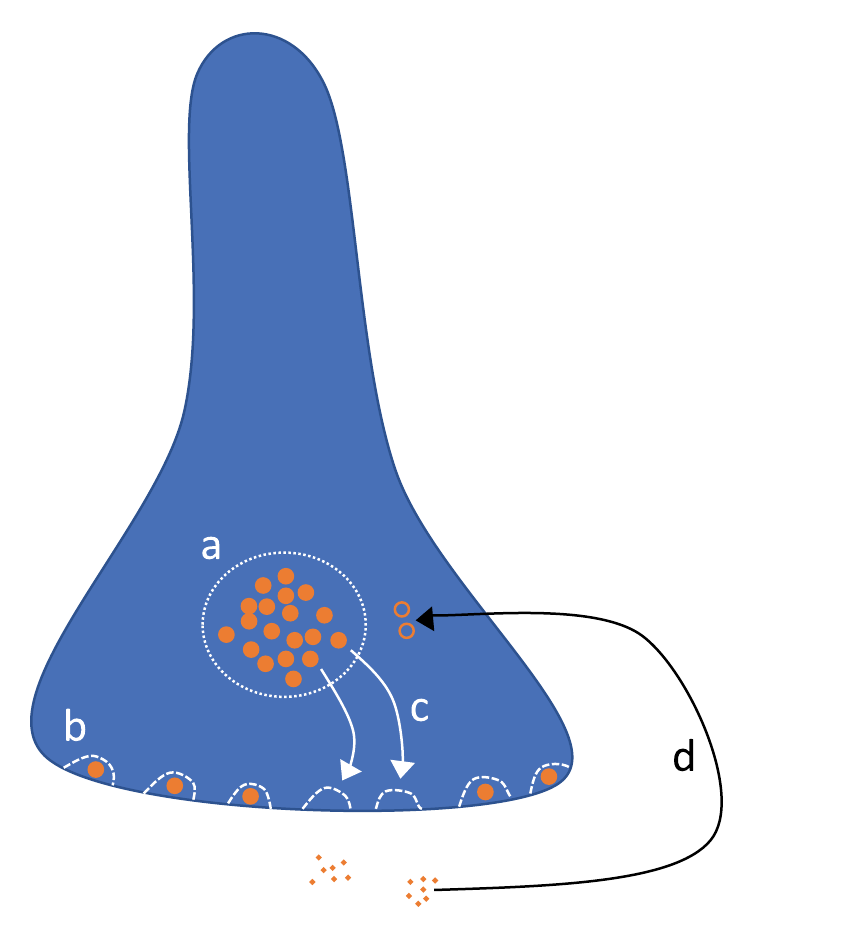
Fig 7. Synaptic depression model. Vesicles are either in the reserve pool (a) or at docking sites (b). Available vesicles dock quickly at empty docking sites (c), but take much longer to regenerate once their internal neurotransmitter is released